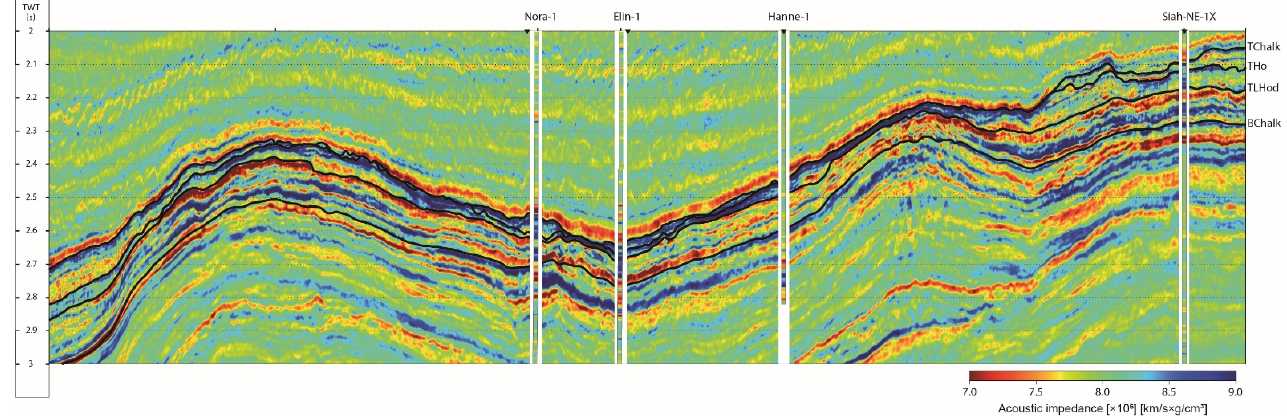
Figure 14. Deterministic inversion result—acoustic impedance (AI) along the composite seismic line. Well trajectories intersected by the composite line are plotted with AI log data where available. The four seismic surfaces used are plotted in black.